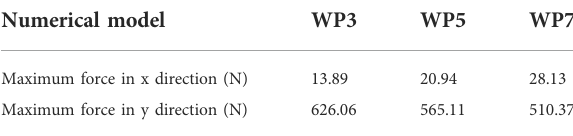
TABLE 4 Maximum force of lower boundary water pressure samples with the same